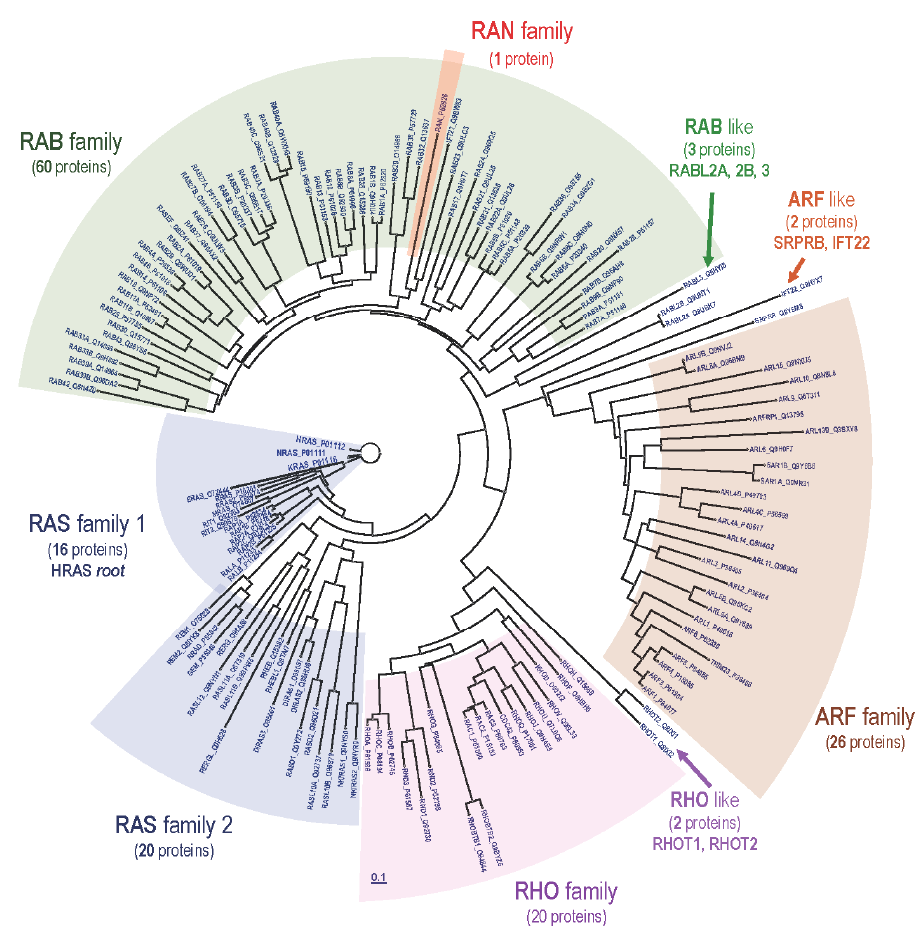
Figure 2. The RAS superfamily. Protein phylogenetic tree, including 150 human small GTPases corresponding to distinct, protein-coding gene loci (proteins annotated in the UniProt database). The HRAS sequence was used as the root for tree construction based on the distance matrix derived from the multiple alignment of the 150 amino-acid sequences using the neighbor joining method [33]. The tree includes 36 members of the RAS family (blue), 20 members of the RHO/RAC family (purple), 26 of the ARF family (brown), 60 of the RAB family (green) and 1 of the RAN family (red). Seven proteins that are frequently unclassified are identified here (pointed by arrows in the figure) as RHO-like (2), ARF-like (2) and RAB-like